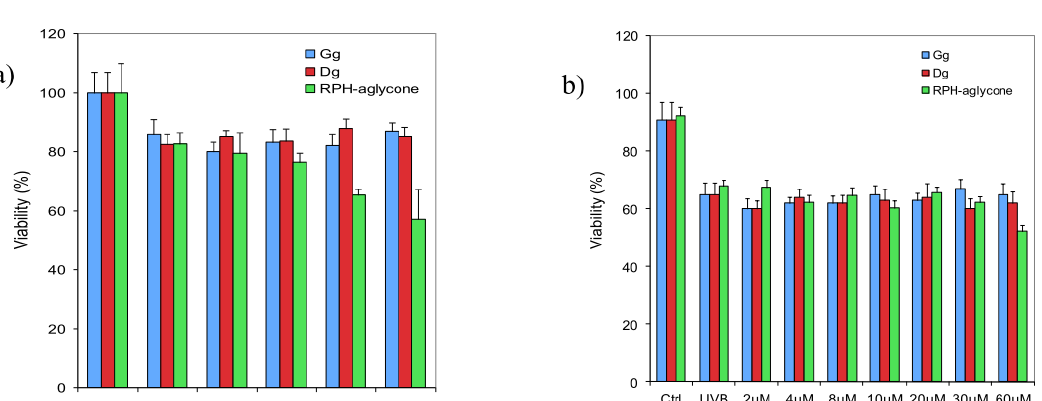
Figure 1. Effects of genistin, daidzin, and RPH-aglycone on the viability of unirradiated or UVB-irradiated skin cells. ( a ) The viability of unirradiated cells was measured with the MTT assay in BJ-5ta cells incubated either with genistin, daidzin or with RPH-aglycone (from 2 µM to 60 µM); ( b ) The viability of UVB-irradiated BJ-5ta cells was measured by Trypan blue staining 24 h after UVB irradiation in cells pretreated with genistin, daidzin, or RPH-aglycone. The results are reported as percentage cell viability, and the values represent the mean values ± SD of three independent experiments (Ctrl: untreated and unirradiated control cells; UVB: untreated and irradiated (60 mJ/cm 2 )